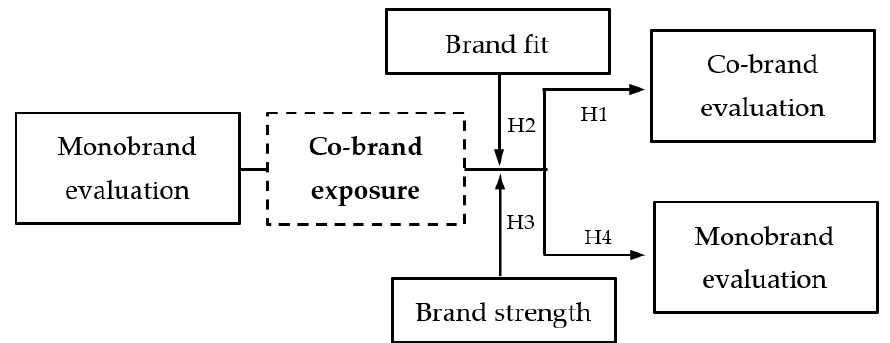
Figure 1. Conceptual research framework.